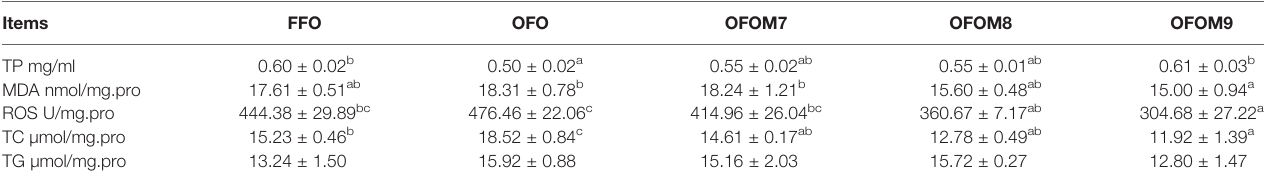
TABLE 4 | The effect of different diet on muscle biochemical indexes of